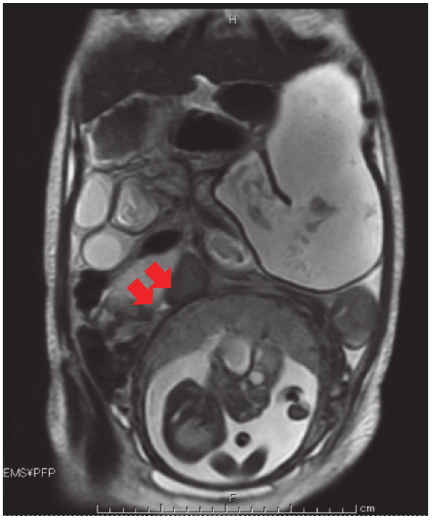
Figure 2: MRI showing the narrowing of the distal extent of the ileum and the dilated proximal intestine (arrows).